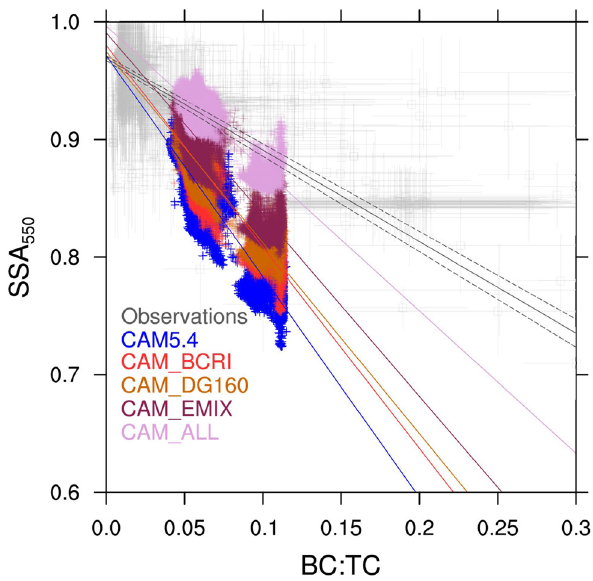
Fig. 4 Model improvement compared to observations with different biomass burning microphysical and radiative properties. Comparison of observed biomass burning (BB) single scattering albedo (SSA) at 550 nm wavelength versus black carbon to total carbon ratio (BC:TC) to CAM5.4 sensitivity tests. Observations are in gray. The CAM5.4